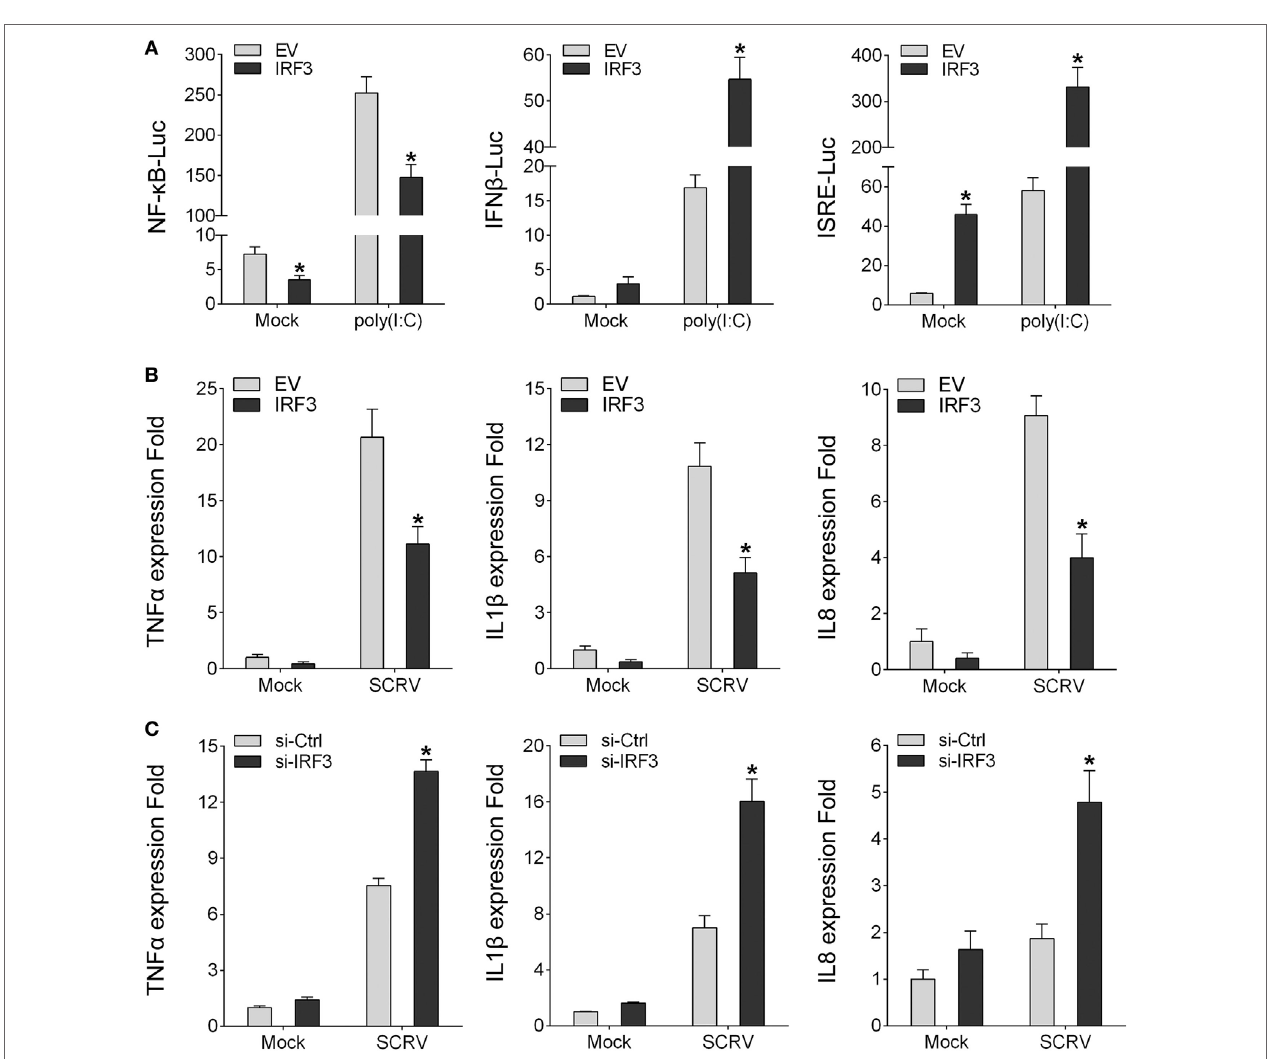
FigUre 2 | IRF3 can inhibit poly(I:C)-induced NF- κ B pathway and expression of downstream cytokines. (a) HEK293 cells were co-transfected with empty vector or IRF3 together with NF- κ B, IFN β , or ISRE reporter gene, after 36 h, stimulated with poly(I:C) for 12 h, then the luciferase activity was measured, the luciferase activity value was achieved against the Renilla luciferase activity. (B) Miiuy croaker macrophages were transfected with empty vector or IRF3, after 36 h, infected with SCRV (MOI = 5) for 12 h, then total RNAs were extracted to examine the expression of TNF α , IL1 β , and IL8 by qRT-PCR. (c) Miiuy croaker macrophages were seeded on 24-well plate overnight and transfected with the scrambled control RNA or si-IRF3, after 36 h, infected with SCRV for 12 h, then total RNAs were extracted to examine the expression of TNF α , IL1 β , and IL8 by qRT-PCR. * p < 0.05 versus the